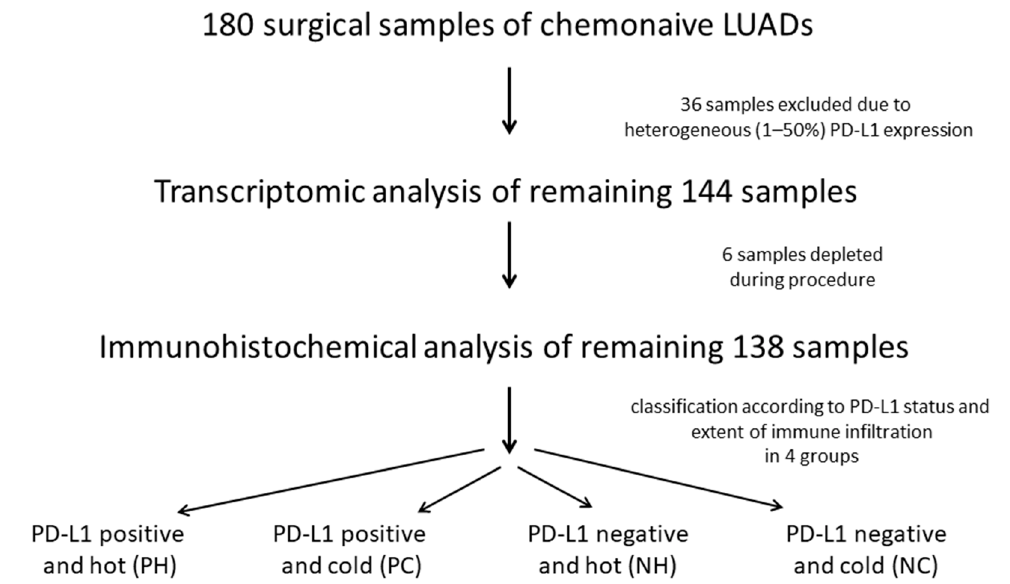
Figure 1. Flowchart showing working steps of the study. Table 1. Patients’ baseline characteristics.